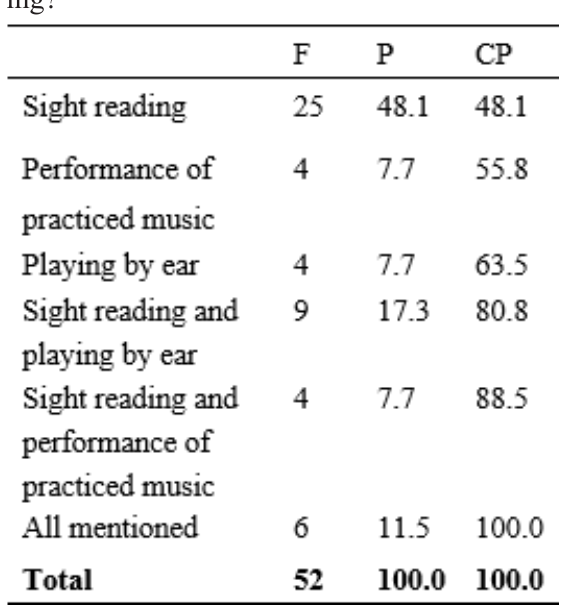
Table 9. Student’s attitudes about